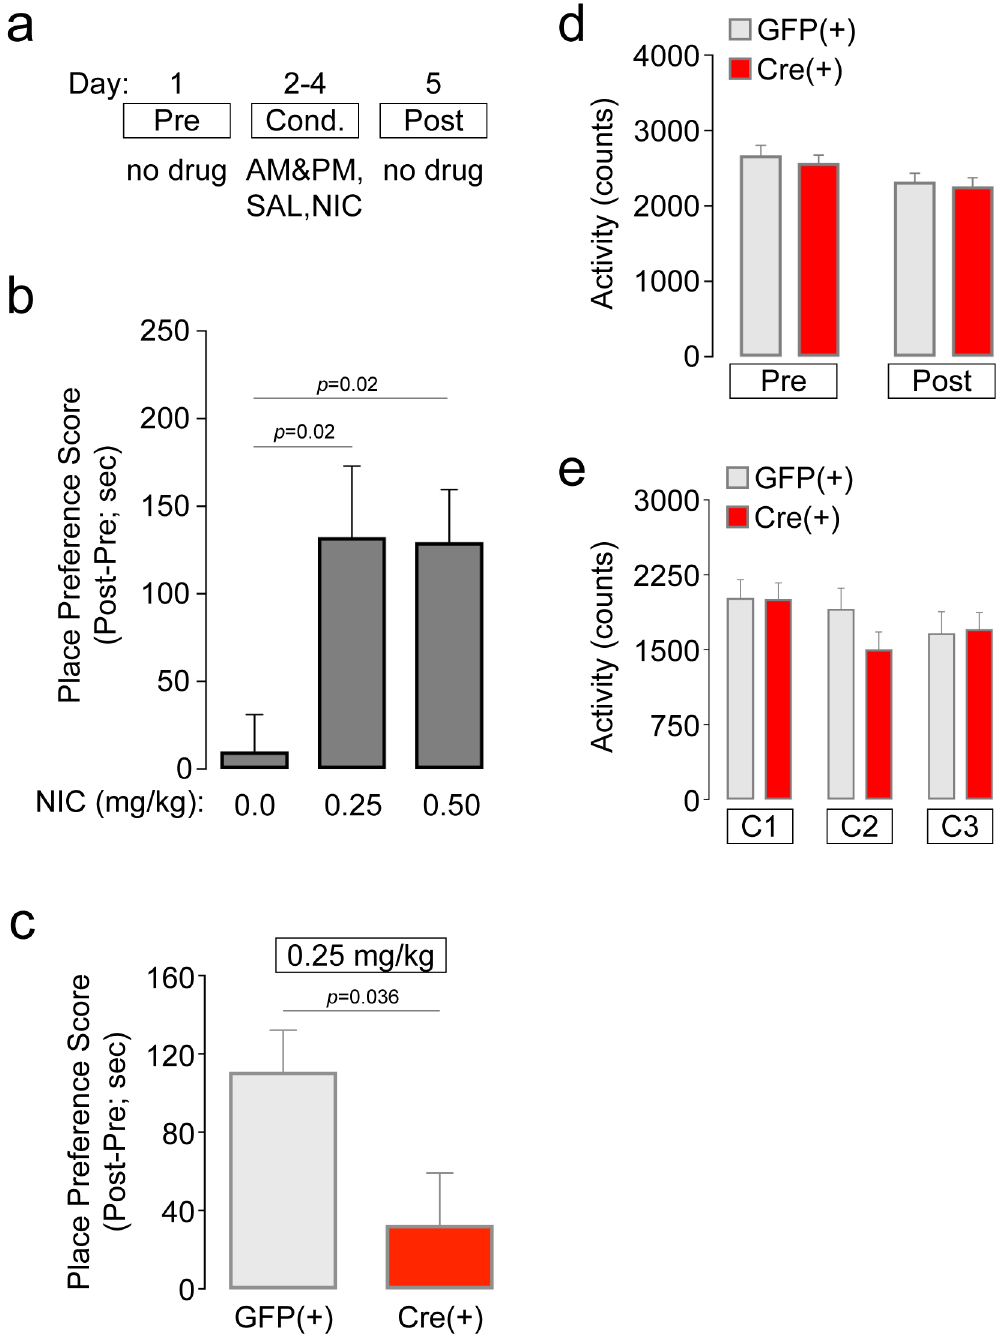
Fig 3. Nicotine CPP is reduced in mice with vMB α 4 deletion. a) CPP schematic. Prior to a 5-day, biasedCPP procedureto establishnicotine CPP, mice were mildly food-restricted and handled.Drug-free pre-test and post-test days flanked3 consecutive conditioningdays that consisted of morning and afternoon saline (SAL) and nicotine (NIC) conditioningsessions. b) NicotineCPP in C57Bl/6WT mice. Groups of WT mice were conditioned with saline (n = 12), 0.25 mg/kg NIC (n = 12), or 0.5 mg/kg NIC (n = 12) to validate our CPP assay and identify a dose to be used subsequently in α 4-flox mice. Mean ( ± SEM) place preferencescore is shown for the three drug doses. p values are for Dunnett’s multiple comparisons test. c) NicotineCPP in α 4-floxmice. AAV-GFP or AAV-Cre-GFP vectors were infused into vMB of α 4-floxmice (GFP(+), n = 10; Cre(+), n = 10), and mice were subsequently conditionedwith 0.25 mg/kg NIC. Mean ( ± SEM) place preferencescore is shown for both groups. p value is for unpairedt-test. d) Mean